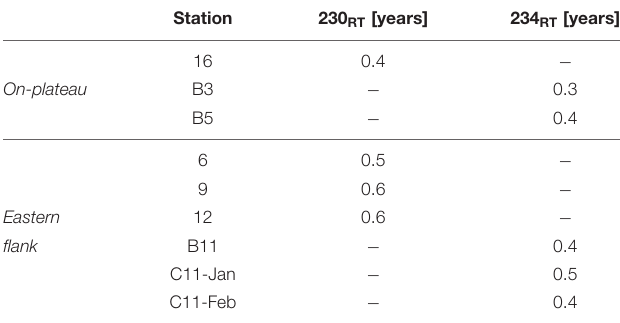
TABLE 2 | Comparison between residence times obtained above 100 m using 230 Th (this study) and 234 Th (Savoye et al., 2008) data from stations located on-plateau and on the eastern flank of the Kerguelen Plateau.